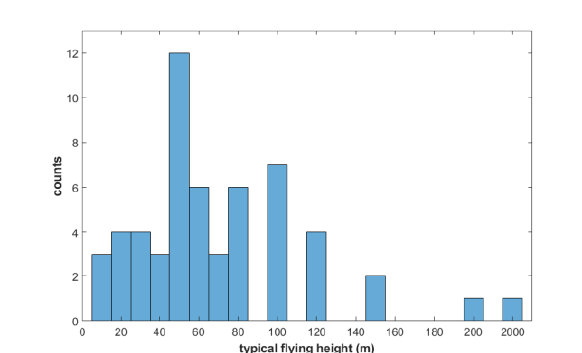
Figure 9 Typical flying height in meter (m) of UAV